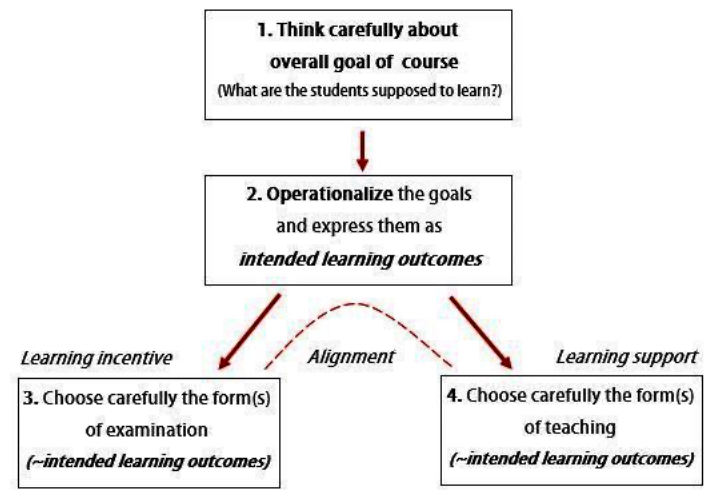
Fig. 2. Alignment implementation process (Abstracted from Braband,